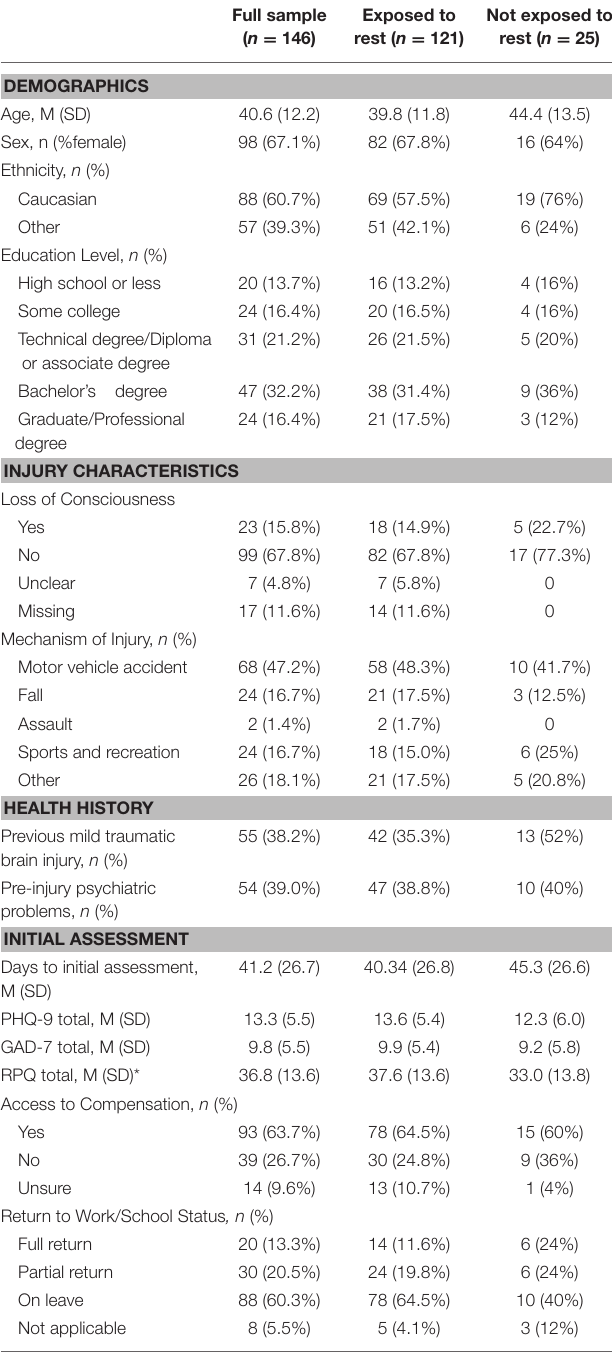
TABLE 1 | Demographic, injury, and initial assessment